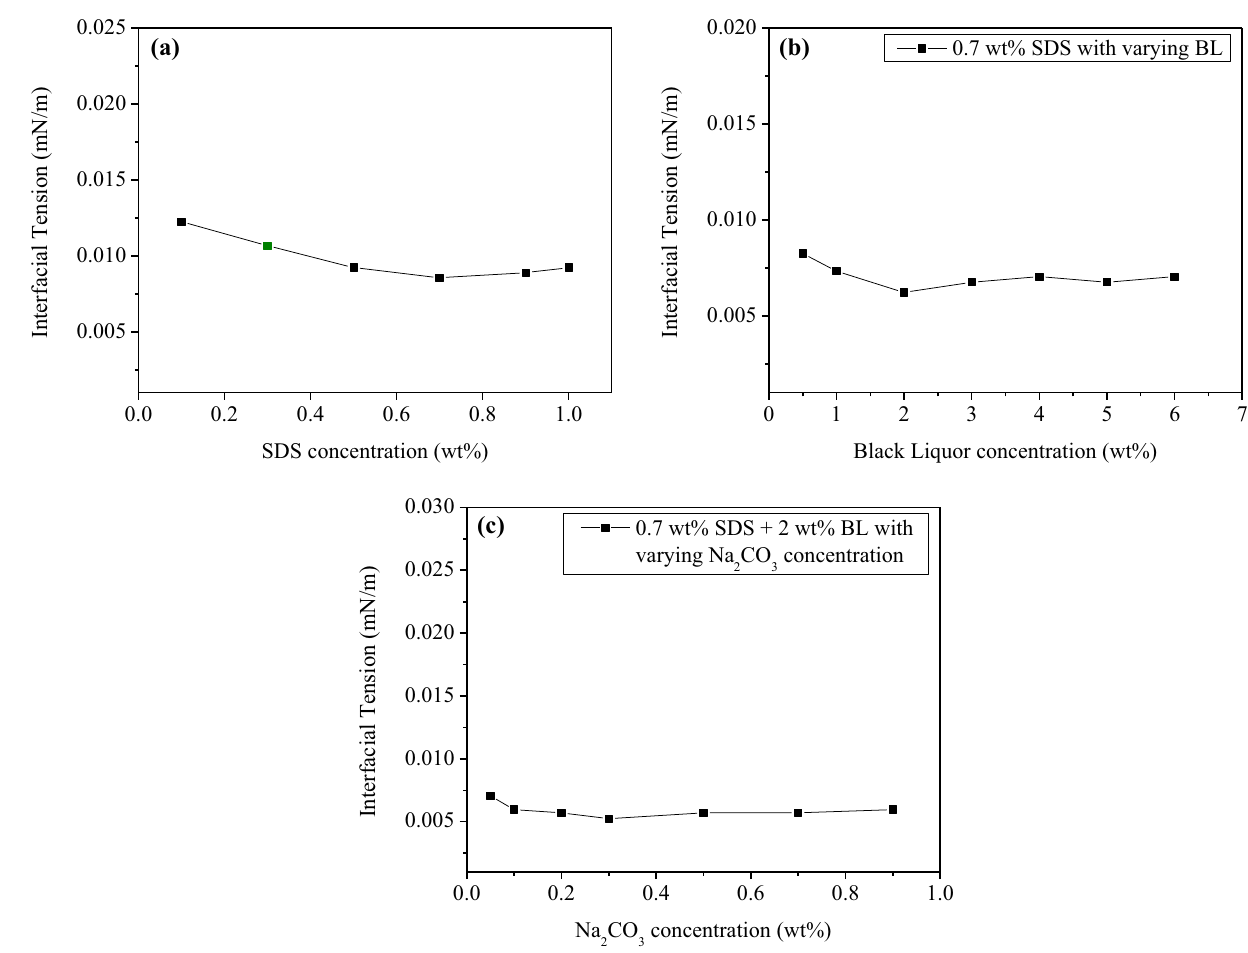
Fig. 4 Interfacial tension of a SDS, b SDS + BL, c SDS + BL + Na